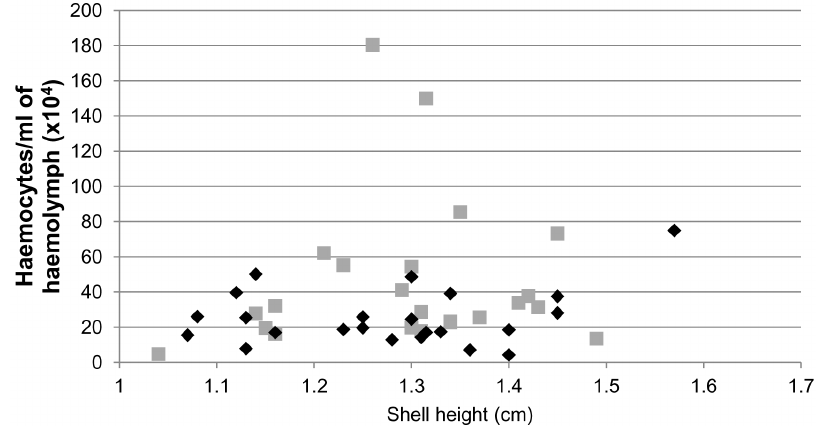
Figure 3. Number of haemocytes/ml of haemolymph of individual uninfected (black diamond) and Trichobilharziaregenti infected (grey box) Radixlagotis . The numbers of haemocytes/ml from individual snails with different shell heights were enumerated using a Bu¨rker haemocytometer.